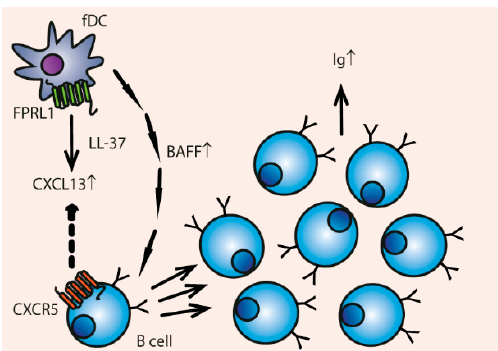
Figure 7. LL-37 induces B-cell attracting chemokines and enhances B-cell proliferation. Follicular DCs (fDCs) produce CXCL13 through LL-37-induced FPRL1 signaling; this chemokine attracts B cells through the CXCR5 receptor. Additionally, the fDCs produce more B cell-activating factor (BAFF), which enhances B cell proliferation and IgA